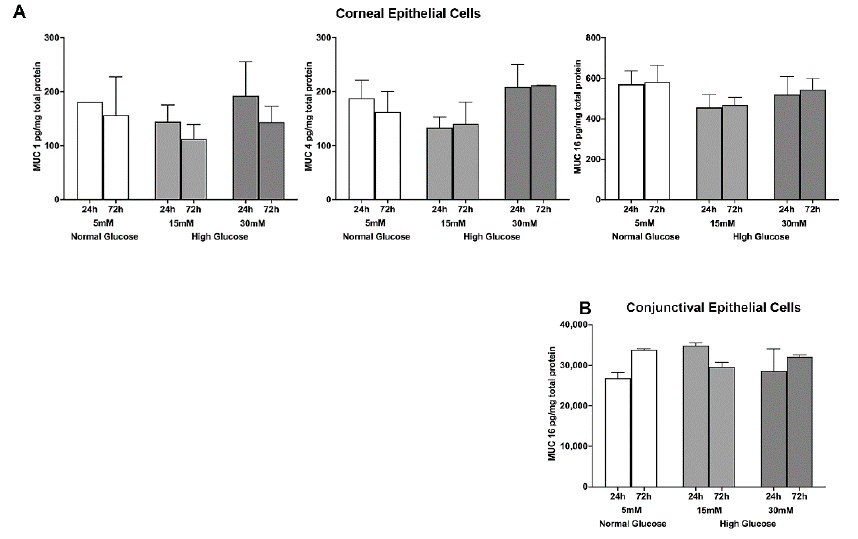
Figure 2. ( A ) Effect of a high glucose level (15 mM; 30 mM) on MUC 1, 4, and 16 protein expression in stratified human corneal epithelial cells. ( B ) Effect of a high glucose level (15 mM; 30 mM) on MUC 1, 4, and 16 protein expression in stratified human conjunctival epithelial cells. The data represent mean + S.E.M of cell culture experiments conducted in triplicate. 2.2. Effect of a High Glucose Level on MUC 16 Barrier Function of Stratified Human Corneal and Conjunctival Epithelial Cell Using Rose Bengal Exclusion Assay Rose bengal is an organic anionic dye that is widely used to assess epithelial damage of the ocular surface [26,27]. Previous studies have shown that ocular surface epithelial cells, upon their expression of MUC 16 and the O-glycosylated Gal β 1-3GalNAc oligosac- charides side chain (T antigen), are resistant to rose bengal staining [26,27]. Thus, to assess the effect of high glucose exposure on the ocular surface’s epithelial barrier function, spe- cifically pertaining to the distribution of MUC 16 and its O-glycosylated side chain, a rose bengal exclusion assay was performed on both stratified corneal and conjunctival epithe- lial cells. As can be seen in Figure 3B left panel, the conjunctival epithelial cells show a remarkably lower level of being stained by rose bengal compared to the corneal epithelial cells (Figure 3A left panel). This is anticipated, because the higher expression of MUC 16 in conjunctival epithelial cells as noted by our ELISA quantification will resist rose bengal penetration and staining, thus resulting in less stained area in the conjunctival epithelial cells compared to that of corneal epithelial cells. Furthermore, the representative images also show that high glucose exposure did not significantly affect rose bengal staining in either the corneal or conjunctival epithelial cells (Figure 3A,B). Consistent with the repre- sentative images, the quantification of the rose bengal-stained area using Image J, as de- picted in the graphs, revealed no significant difference between the normal glucose- and high glucose-exposed epithelial cells (Figure 3A,B).